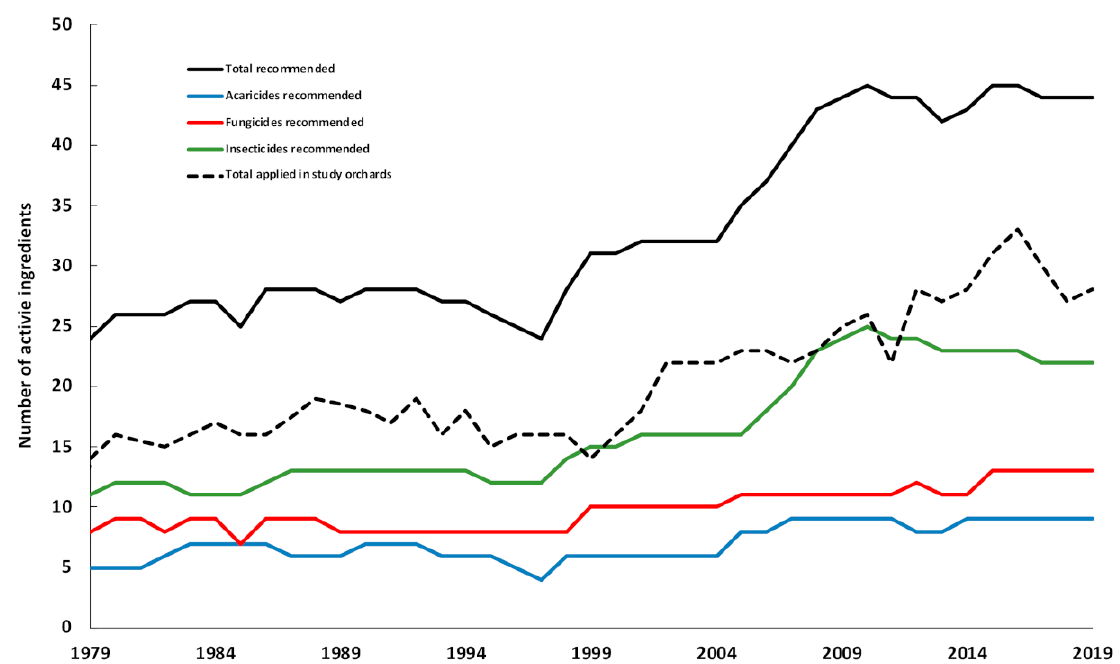
Figure 8. Number of active ingredients of pesticides recommended for use in apple orchards from 1977 to 2019. Compiled from recommendations by the Quebec Government (references: see Table